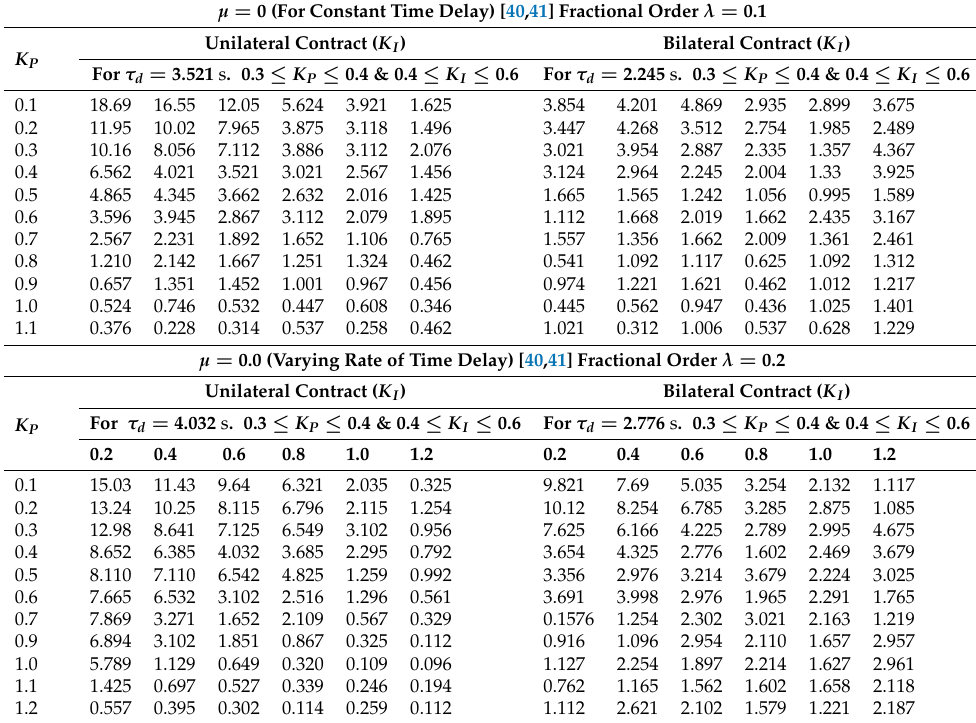
Table 3. Delay margin for FOPI controller for λ = 0.1 and 0.2